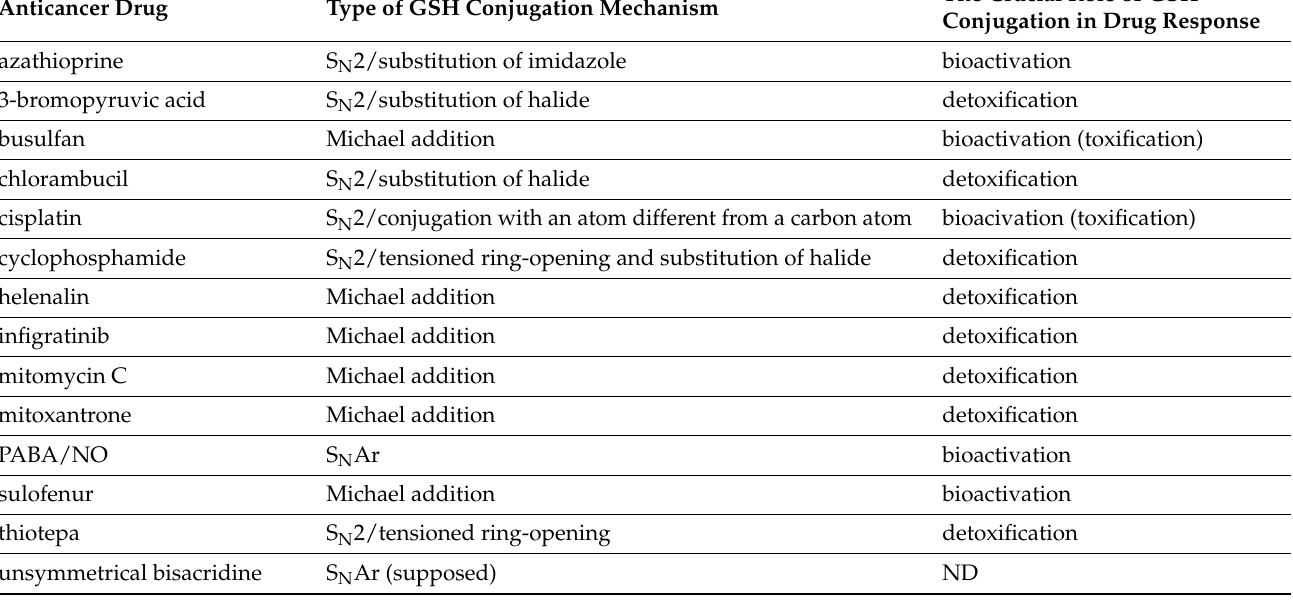
Table 1. Overview of the mechanisms and the role of GSH conjugation of anticancer drugs discussed in this